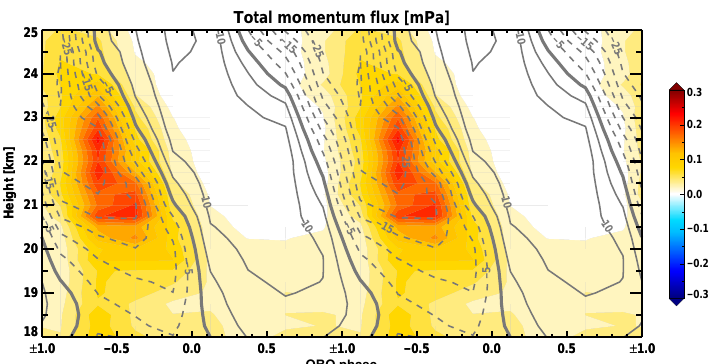
Figure 7. Composite momentum flux in shading and composite zonal mean zonal winds in gray contours, both as functions of QBO i (see text for details). Zonal wind contour spacing is 5ms − 1 and the 0ms − 1 contour is bolded. Two full cycles of the composite QBO are shown here to ease visual inspection.